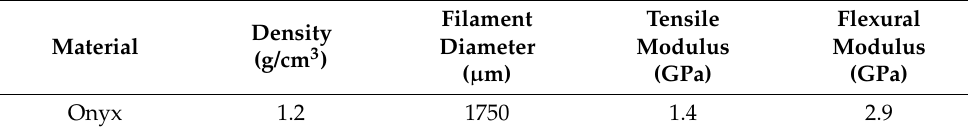
Table 1. Onyx mechanical features.